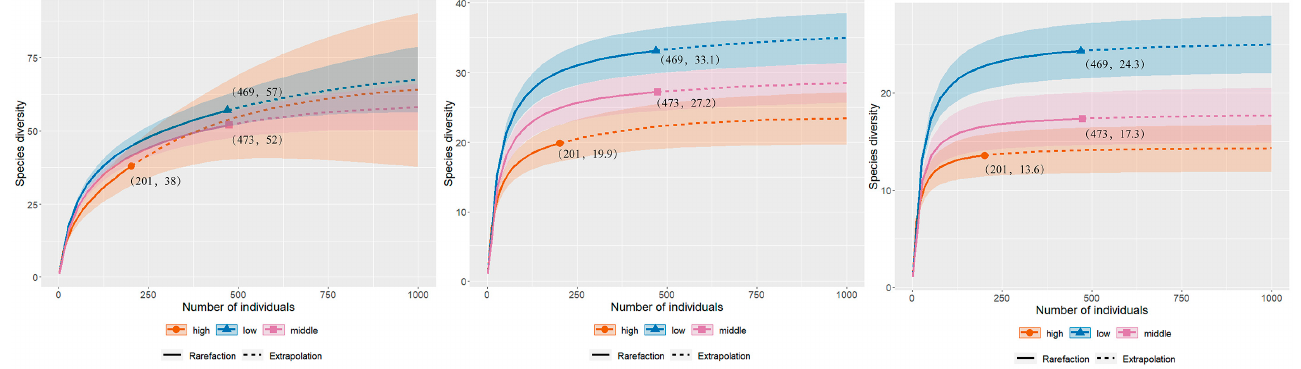
Figure 3. Sample-size-based rarefaction (solid line) and extrapolation (dotted line) sampling curves with 95% confidence intervals (shaded areas) for three different elevations, separately by diversity order: q = 0 (species richness, left panel), q = 1 (Shannon diversity, middle panel) and q = 2 (Simpson diversity, right panel). The solid dots/triangles/squares represent the reference samples.